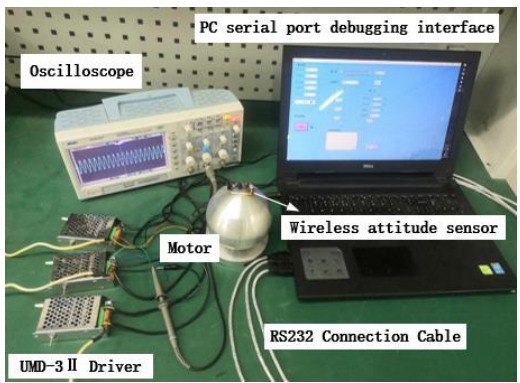
Figure 14. Output performance experimental test platform.